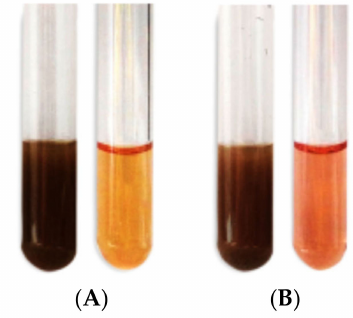
Figure 5. Visual representation of biosynthesis of AgNPs from pomegranate peel extract ( A ) and orange peel extract ( B ).